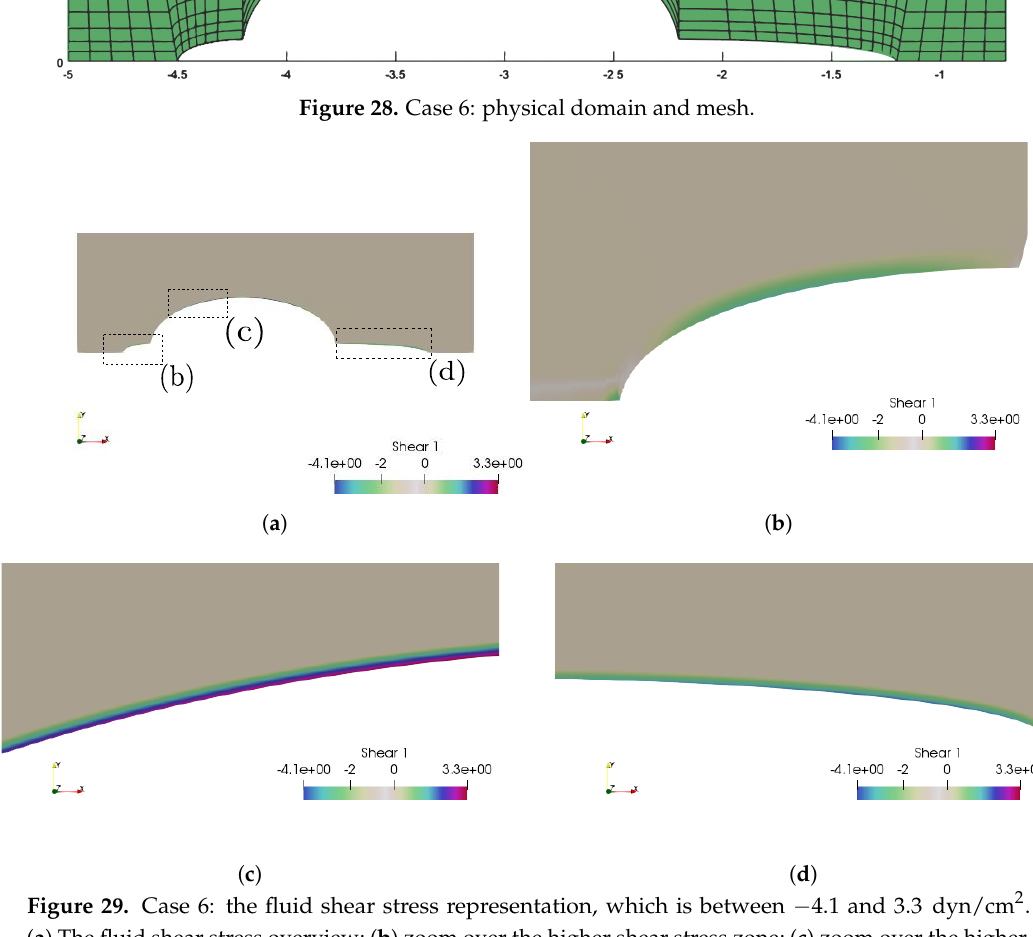
Figure 29. Case 6: the fluid shear stress representation, which is between − 4.1 and 3.3 dyn/cm 2 . ( a ) The fluid shear stress overview; ( b ) zoom over the higher shear stress zone; ( c ) zoom over the higher shear stress zone; ( d ) zoom over the higher shear stress zone.